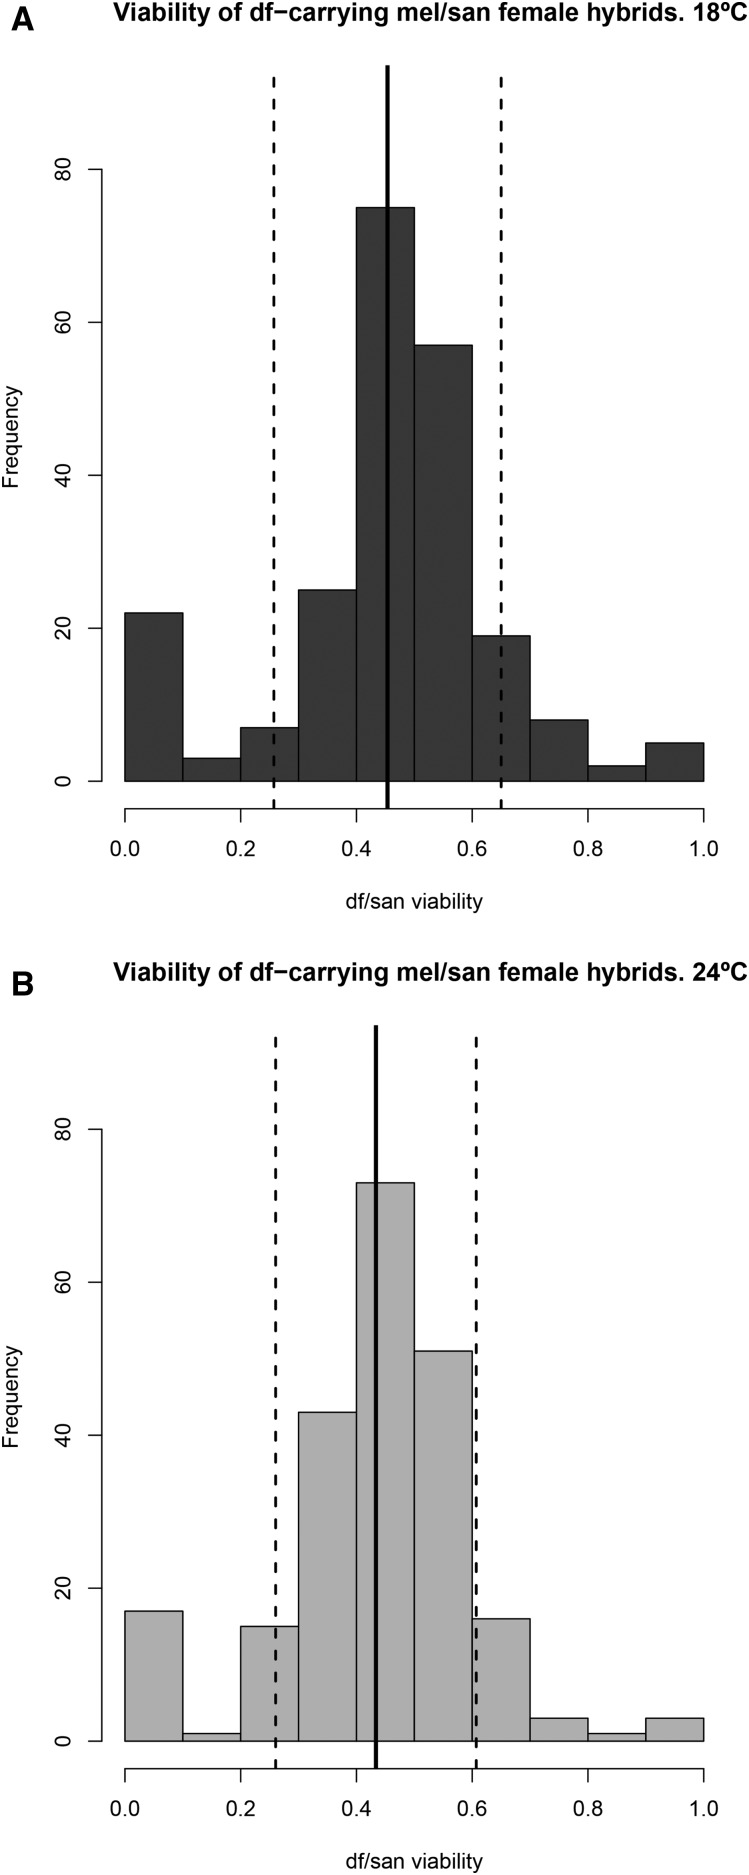
Relative fitness frequencies of the df-carrying hybrids in mel/san hybrids at two different temperatures. (A) mel/san 18°. (B) mel/san 24°. Black solid lines in each panel show the mean fitness of the df-carrying hybrids. Black dashed lines show the mean ± SD of the mean. The x-axis shows relative viability of deficiency-carrying progeny (observed df-carrying progeny/observed Bal-carrying progeny + observed df-carrying progeny) while the y-axis shows the number of stocks having a given level of viability of deficiency carrying offspring. Bal, balancer chromosome; df, deficiencies; mel, D. melanogaster; san, D. santomea.